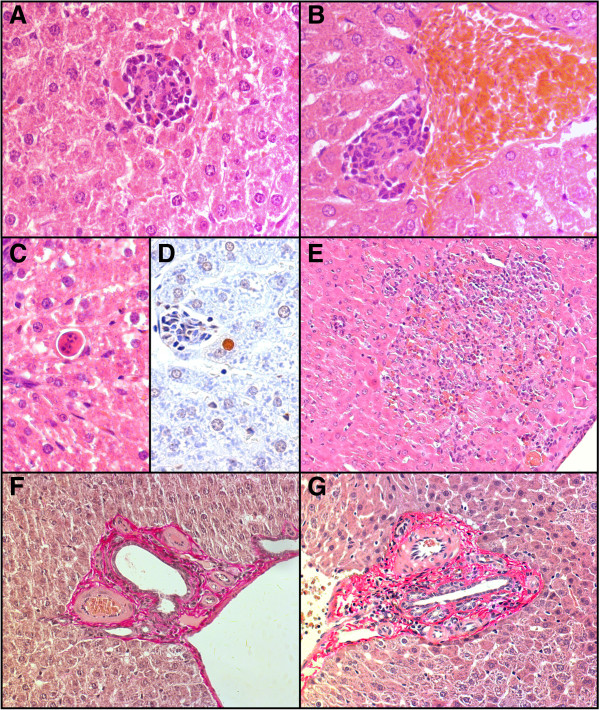
Histological images of livers from animals treated with SAS or NM-202 for 28 or 84 days. (A, B) Light microscopic images of an inflammatory granuloma after 84-days of exposure for (A) SAS high dose (magnification: 200x), and (B) NM-202 high dose (magnification: 200x). (C) Apoptosis after 28-days of exposure (SAS low dose, H&E staining; magnification: 200x), and (D) apoptosis after 28-days of exposure (NM-202 high dose; immunohistochemically stained apoptosis; magnification: 200x). (E) Necrosis after 28-days of exposure (NM-202 medium dose; magnification: 25x), and (F, G) fibrosis after 84-days of exposure to the (F) SAS high dose (magnification 100x), and (G) NM-202 high dose (magnification 100x).